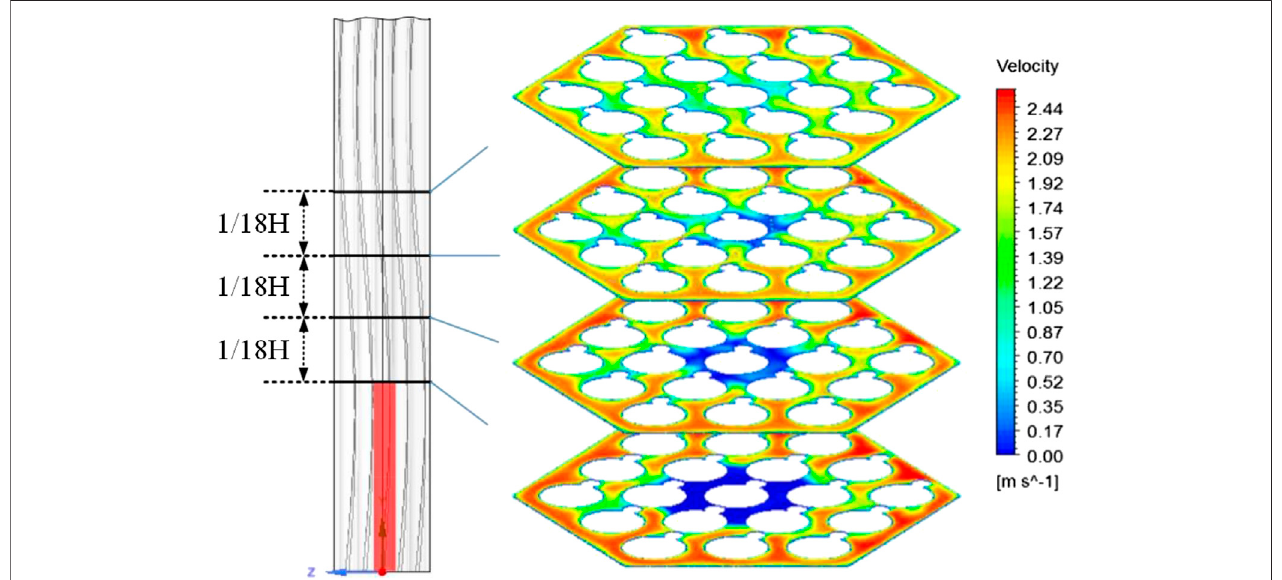
FIGURE 7 | The velocity contours downstream of the blockage.